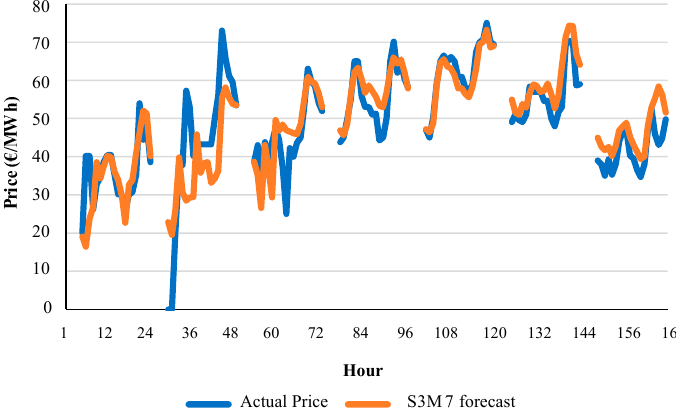
Figure 9. Actual price values and forecast values of model S3M7 of intraday session 3 for week 7 of year 2013.